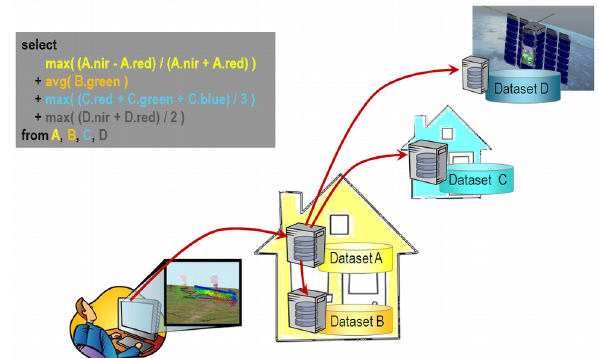
Figure 1. Sample query splitting and distribution in rasdaman